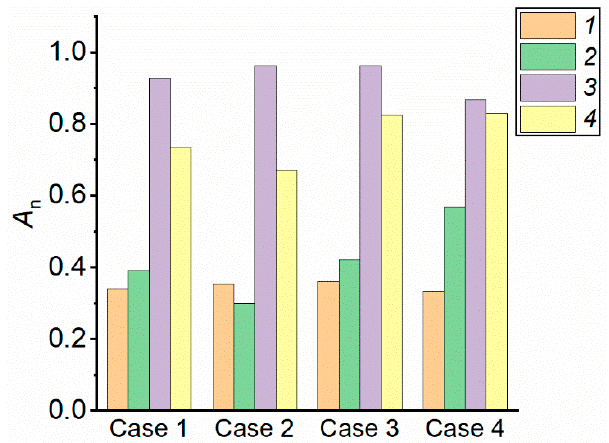
Figure 8. Relative efficiency factor of fire extinguishing agents when varying the weighting factors: 1 —water; 2 —bentonite slurry; 3 —bischofite solution; and 4 —foaming agent solution.